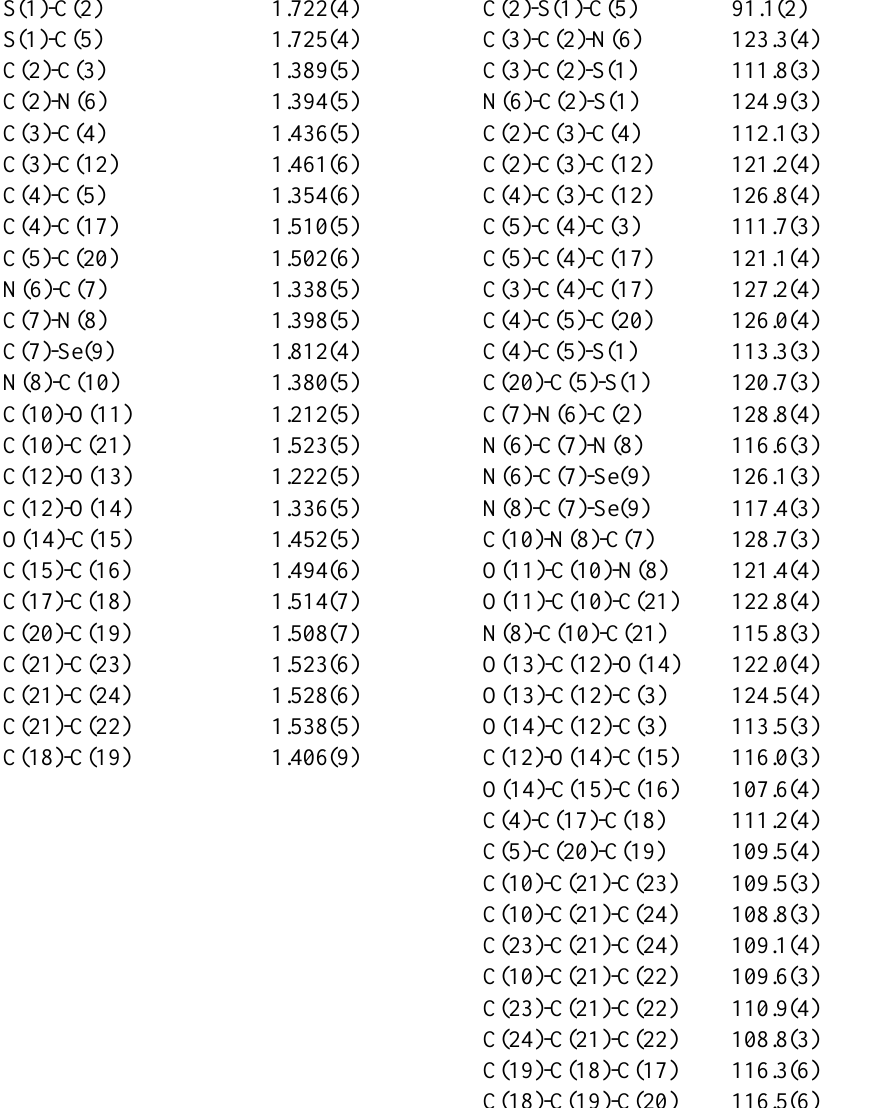
Table 6. Bond lengths [Å] and angles